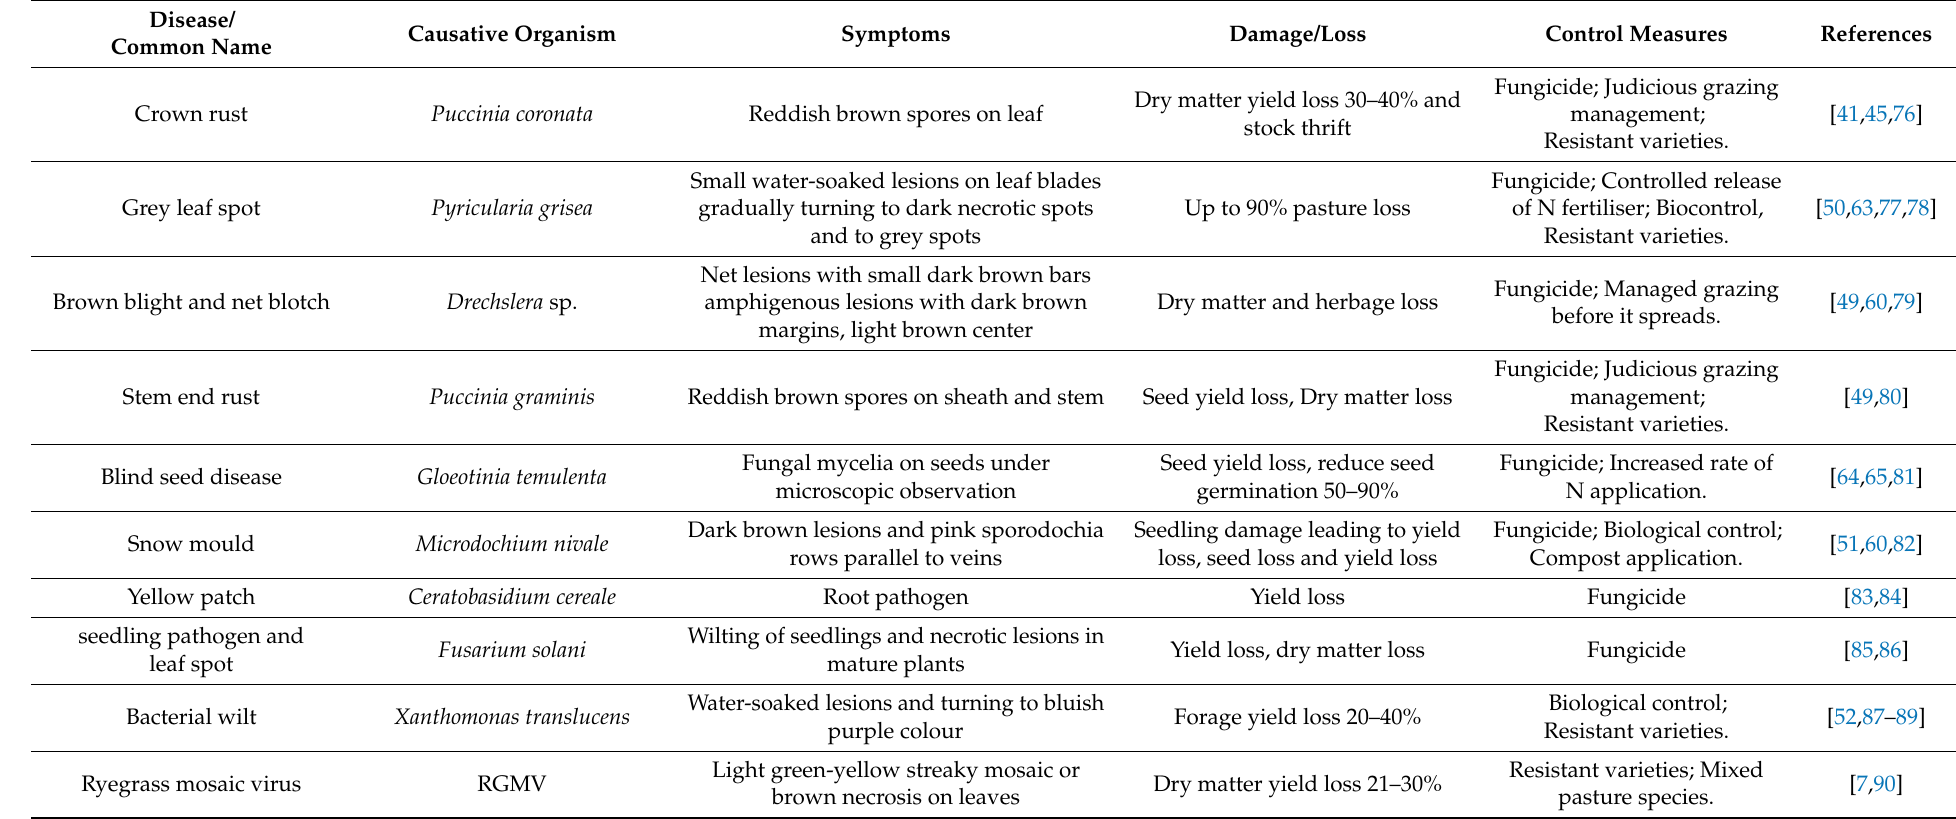
Table 2. Common disease-causing phytopathogens in pasture and turf